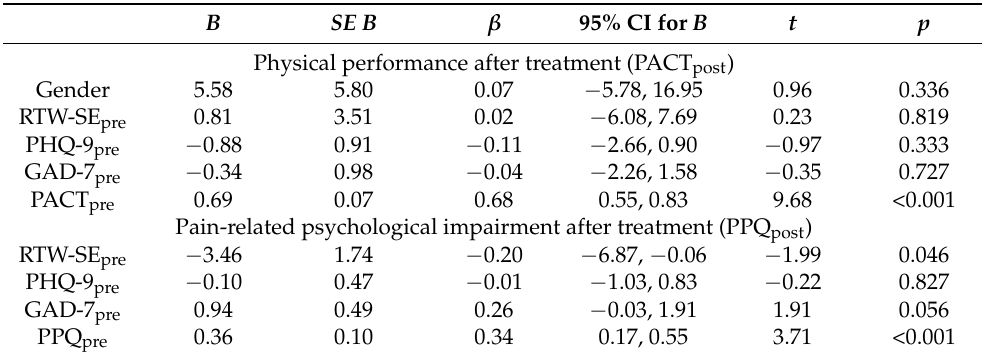
Table 5. Results of multiple regression analysis with the criteria of physical performance and pain- related psychological impairment after